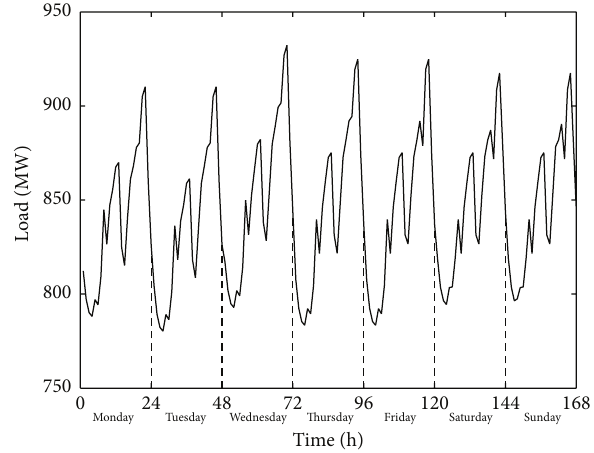
Figure 5: Weekly load curve.